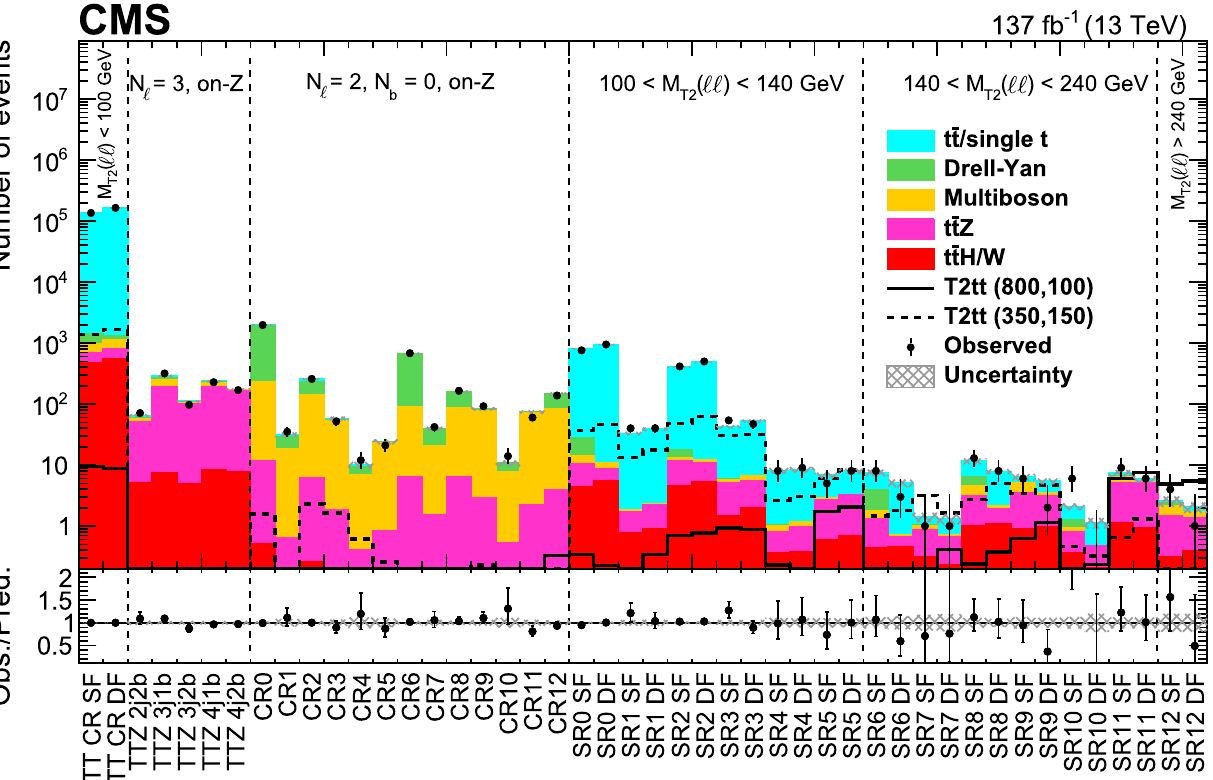
Fig. 5 Predicted and observed yields in the signal and control regions asdefinedinTables3and4.ThecontrolregionsTTCRSFandTTCRDF are defined by M T2 ((cid:5)(cid:5)) < 100GeV and are used to constrain the t ¯ t nor- malization. The t ¯ tZ control regions employ a 3 lepton requirement in different N jets and N b bins. The dilepton invariant mass and N b selec-